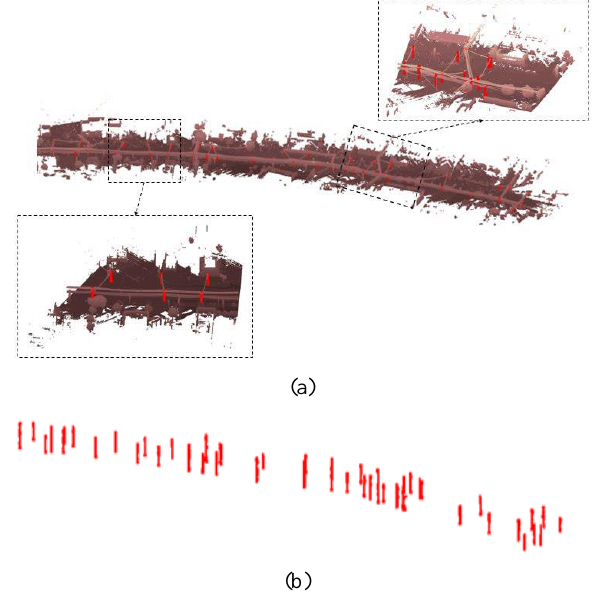
Figure 13. Output of the proposed algorithm which identified by red color. The proposed method successfully extracted 49 poles among 50 poles available at the urban